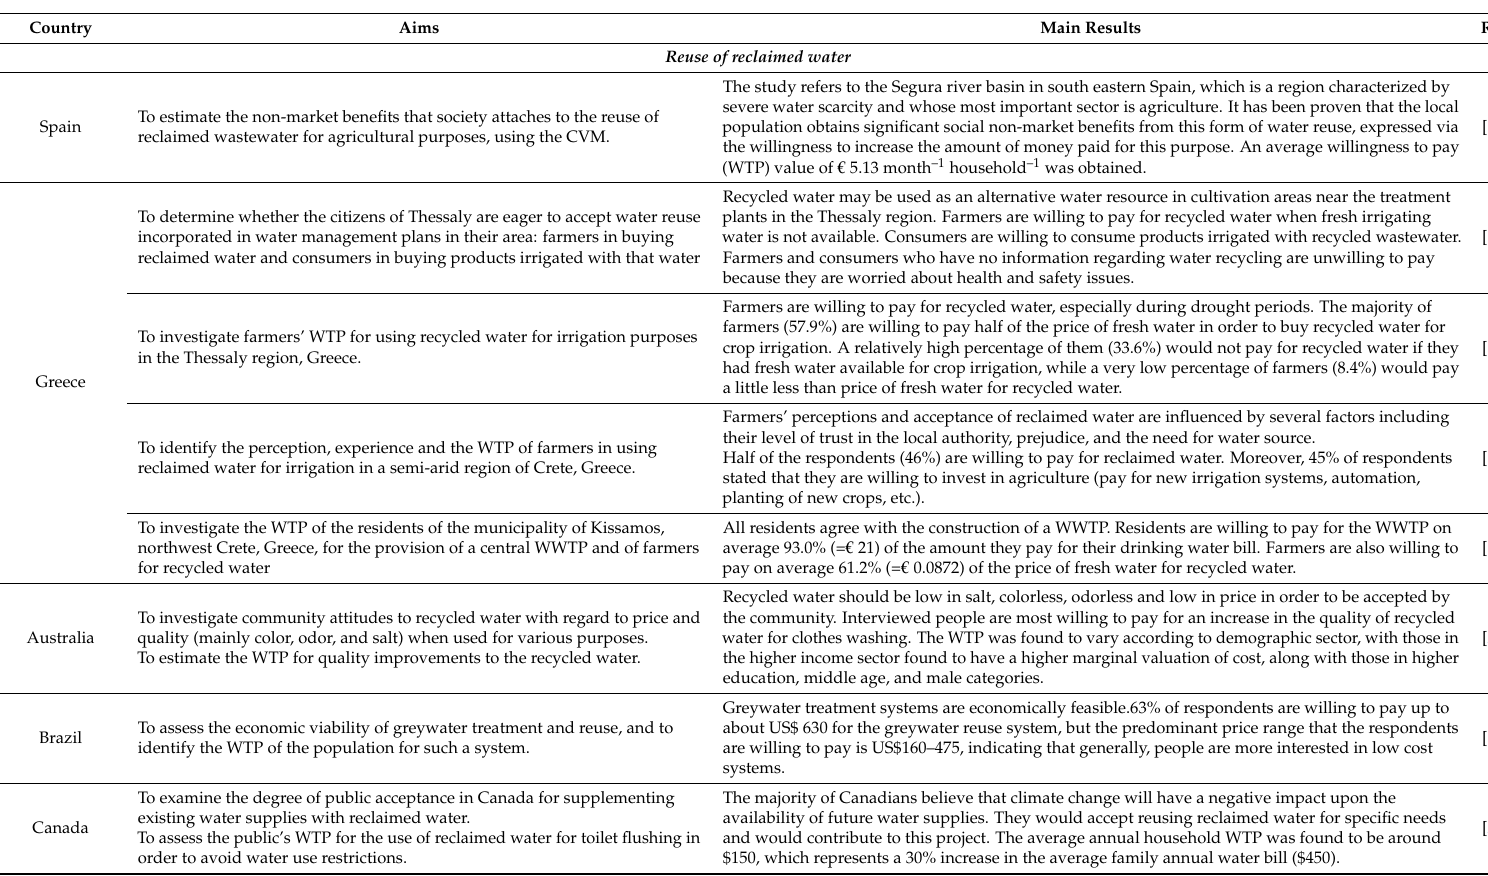
Table 1. Selection of published studies applying contingent valuation method (CVM) in cost-benefit analyses of different projects, grouped according to the study scope and